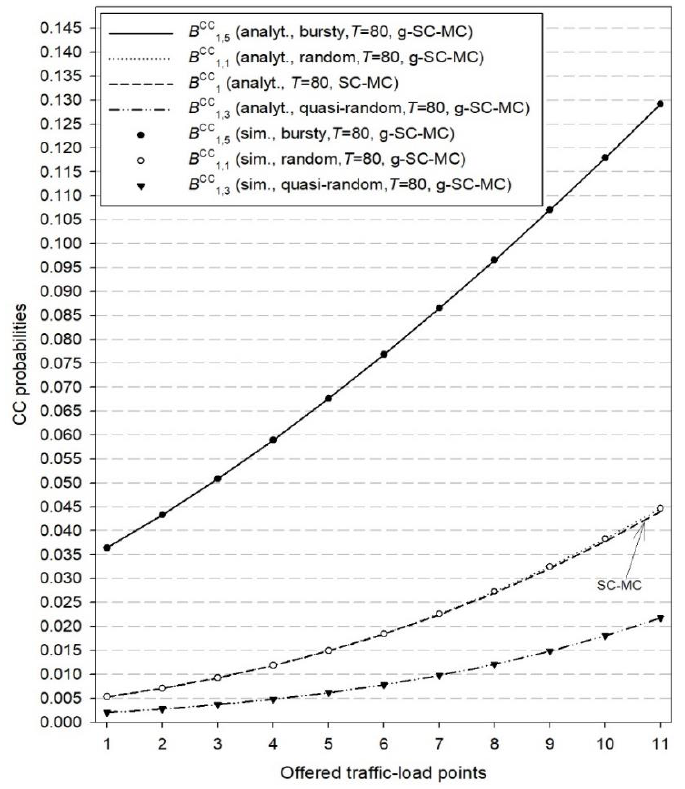
Figure 4. CC probabilities ( CC